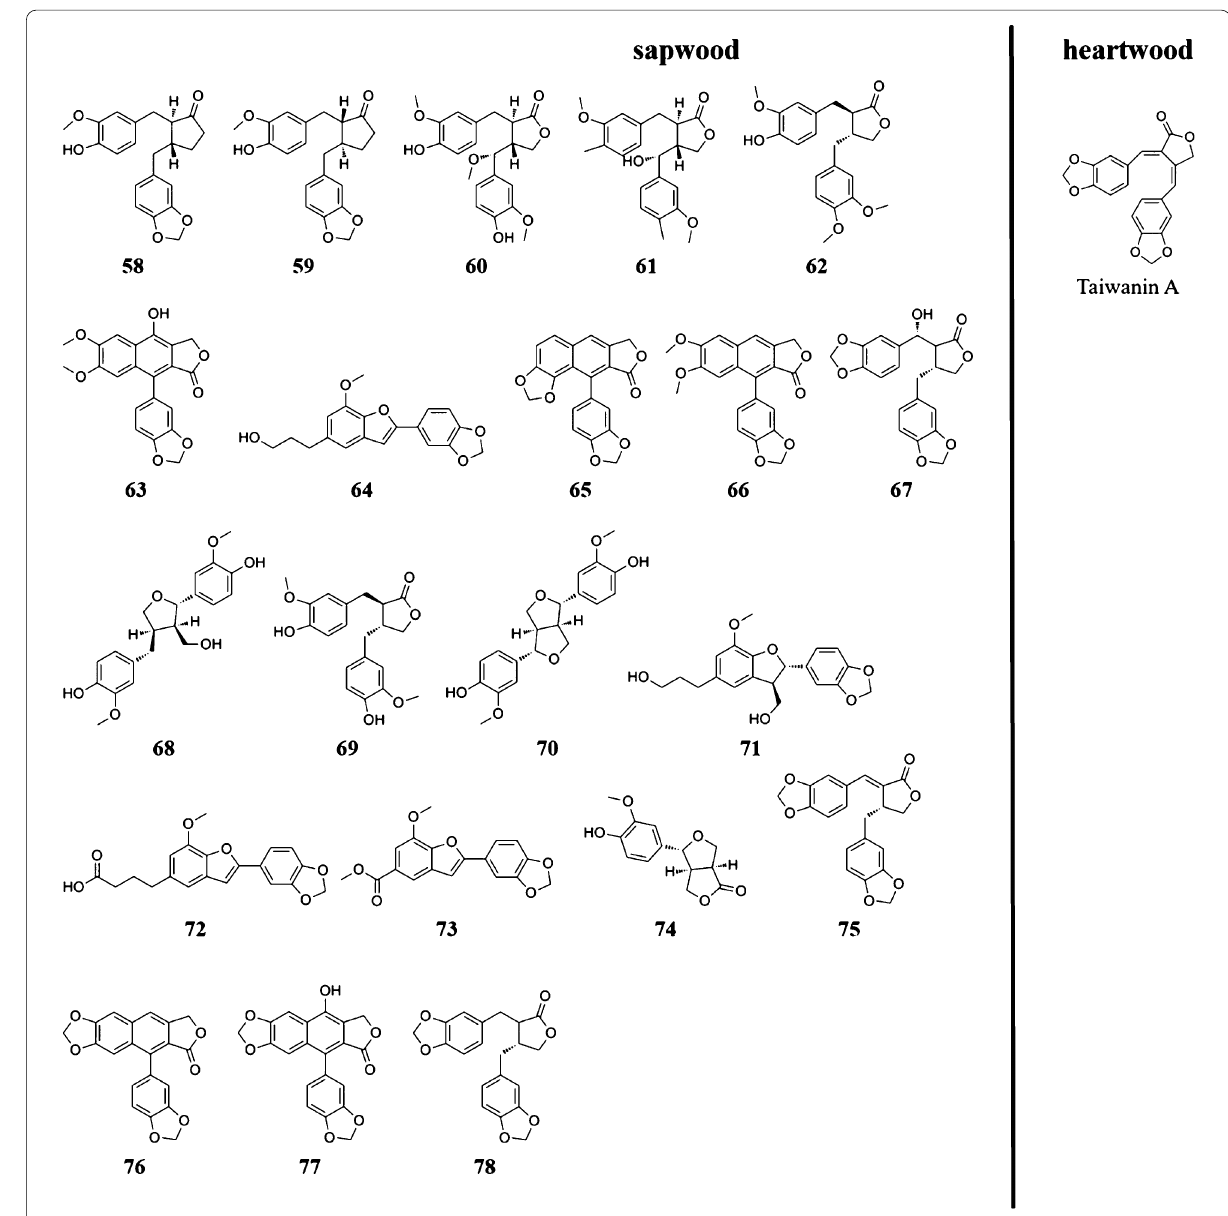
Fig. 2 Lignans and norlignans identified in sapwood. Taiwanin A was only found in